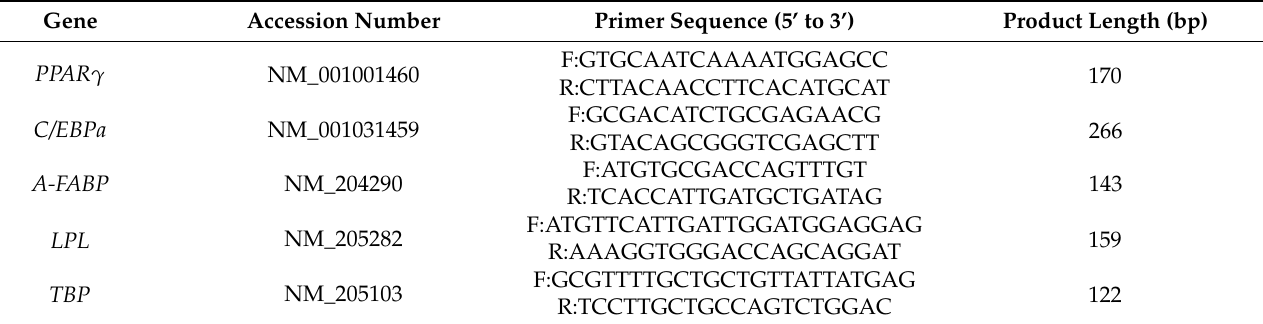
Table 1. RT-qPCR primer